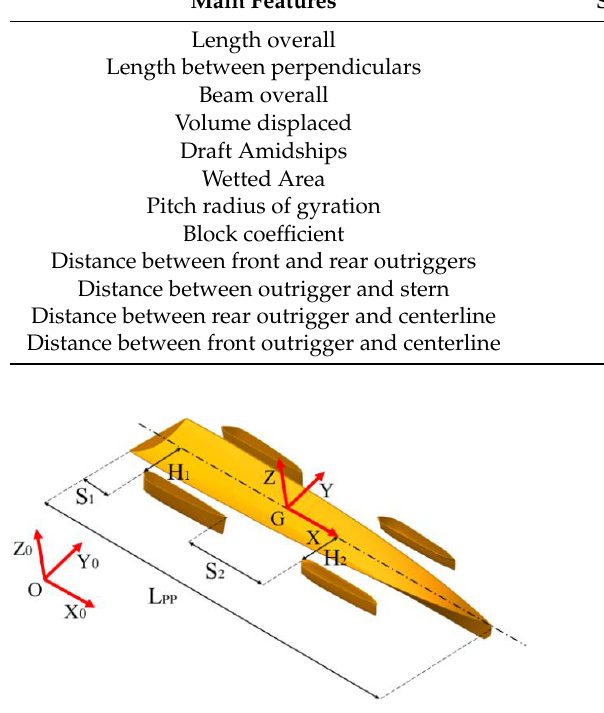
Figure 1. Pentamaran.